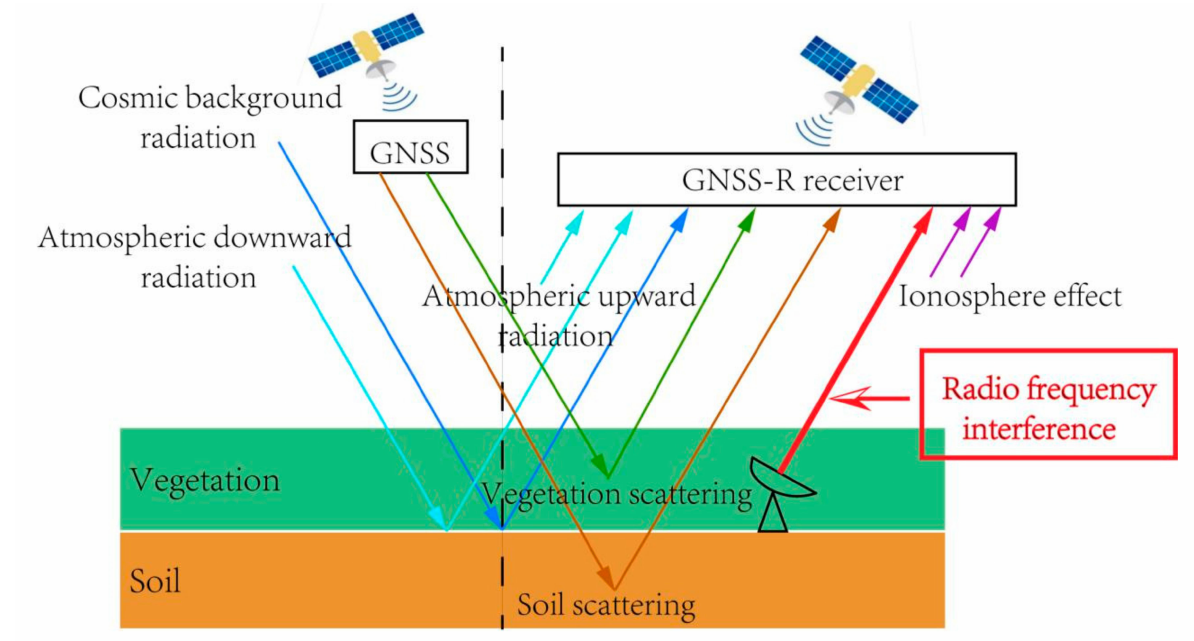
Figure 10. RFI effects on the final GNSS-R